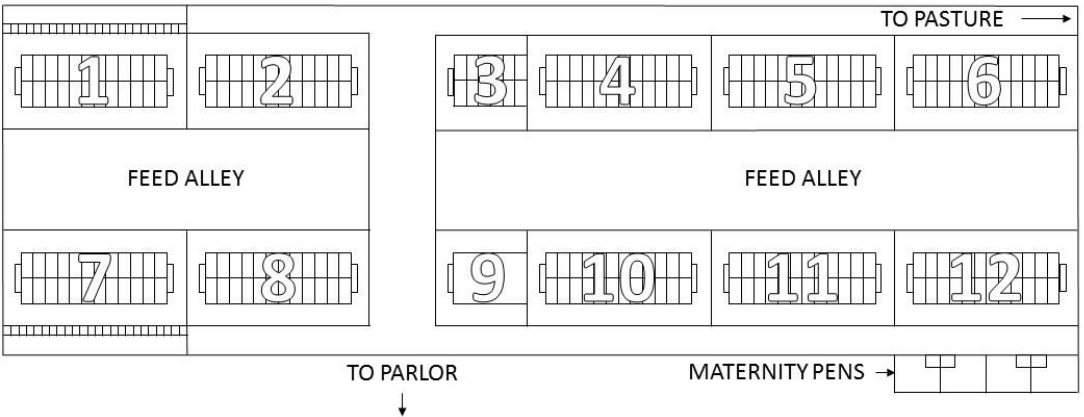
Figure 1. Diagram of University of Tennessee’s Little River Animal and Environmental Unit